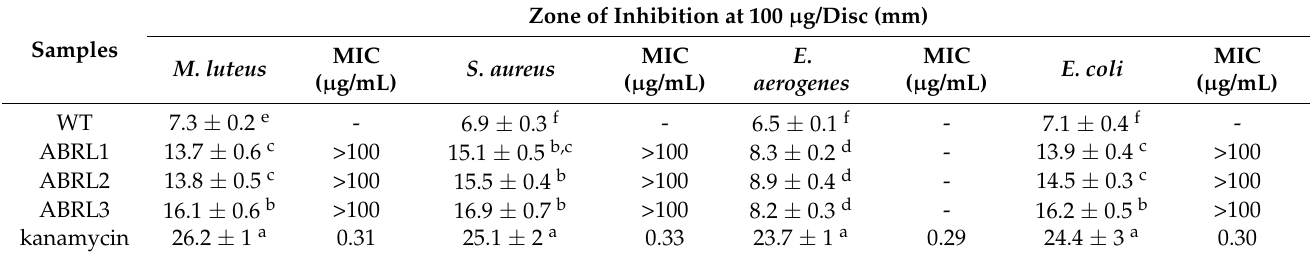
Table 2. Antibacterial activity of A . bracteosa .